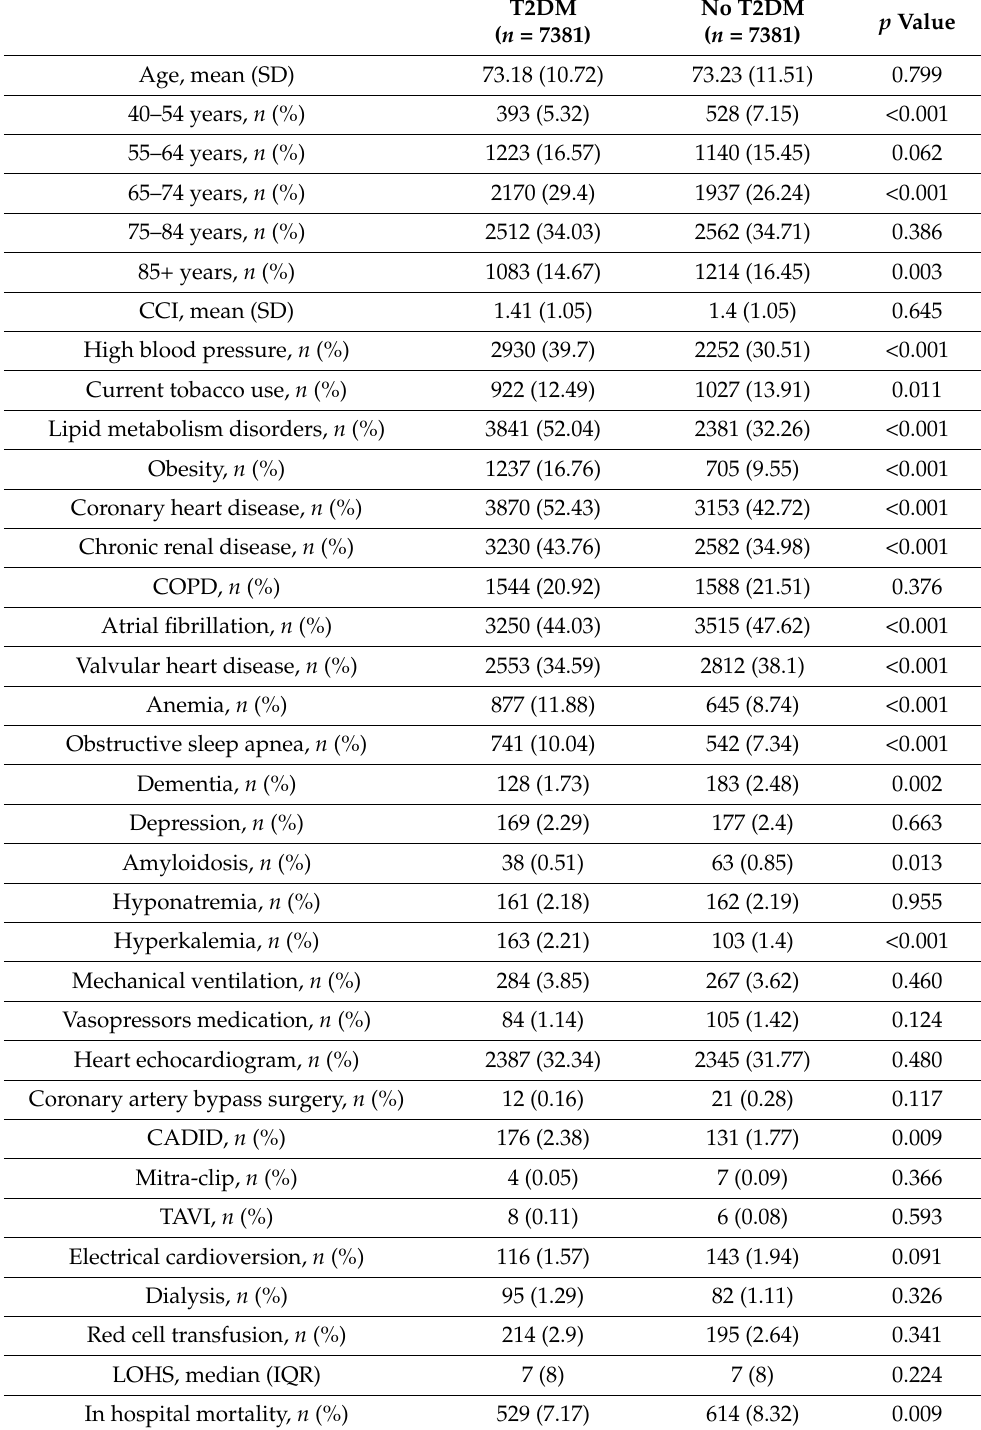
Table 2. Demographic and clinical characteristics, after propensity score matching, of men with and without type 2 diabetes mellitus hospitalized with systolic heart failure in Spain from 2016 to